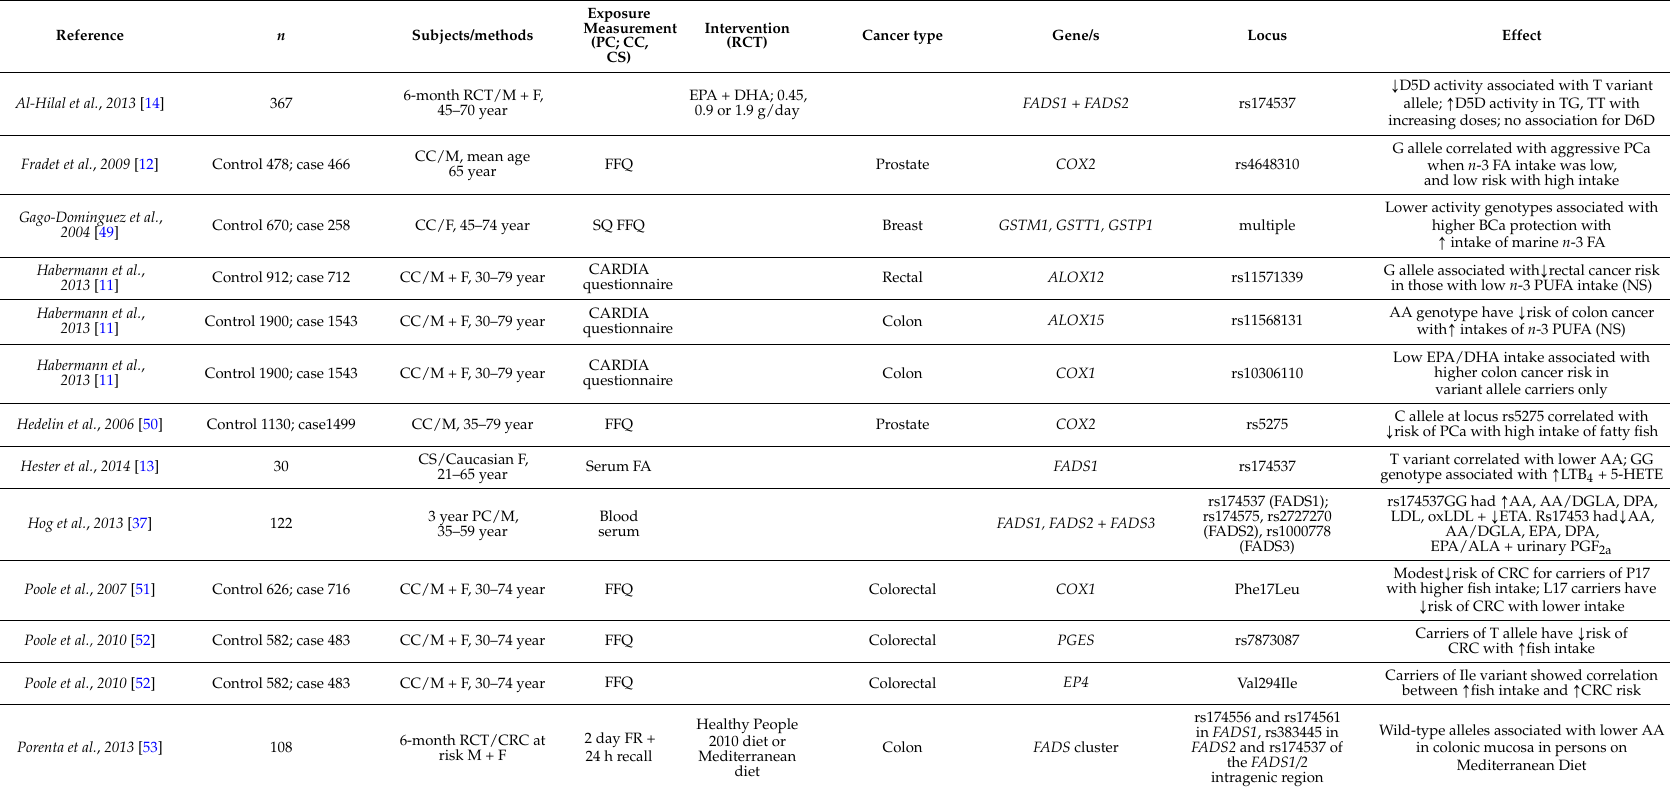
Table 1. Polymorphisms associated with LC n -3 PUFA intake and cancer